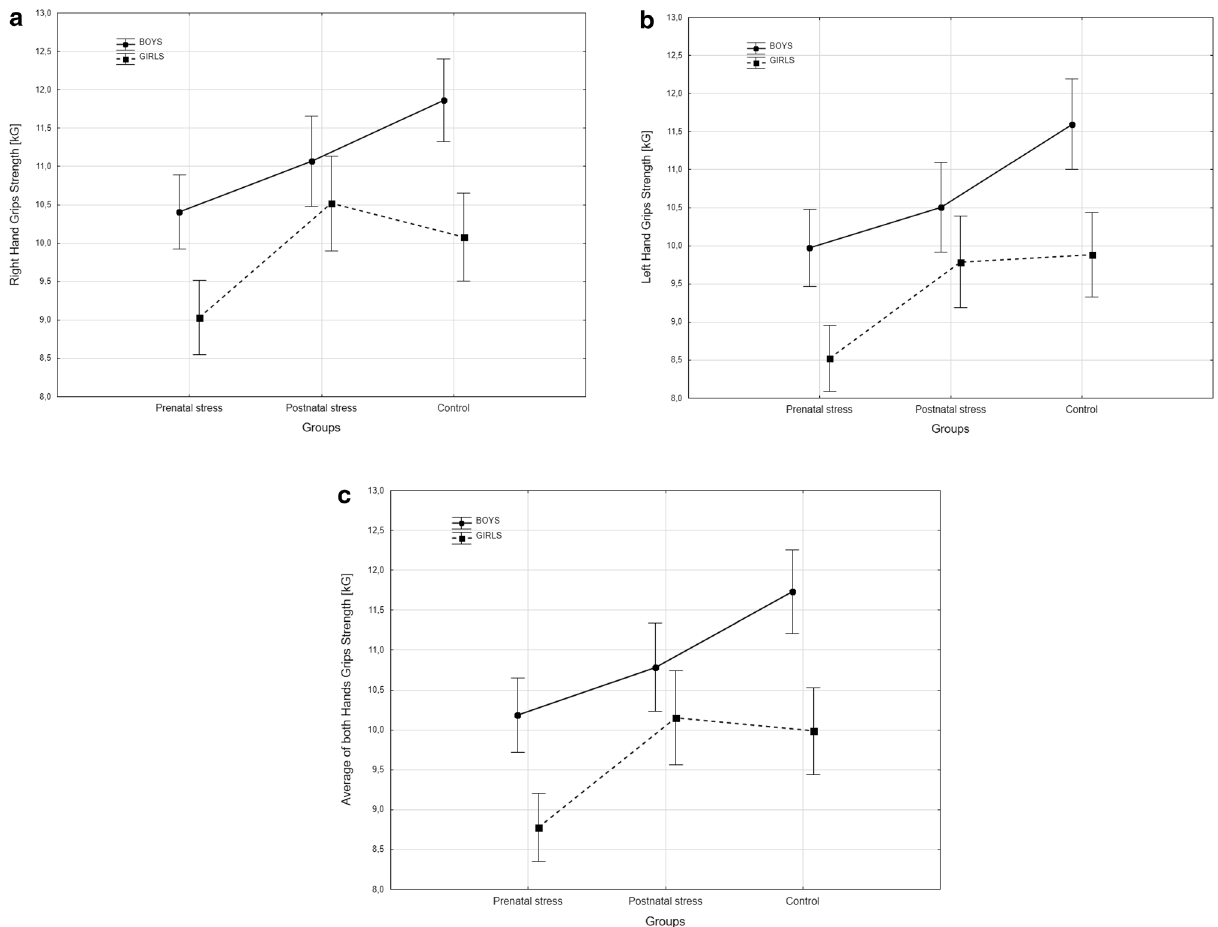
Figure 1. ( a , b ) Weighted marginal means of right ( a ), left ( b ) and average ( c ) HGS in boys and girls by experimental groups and controls.